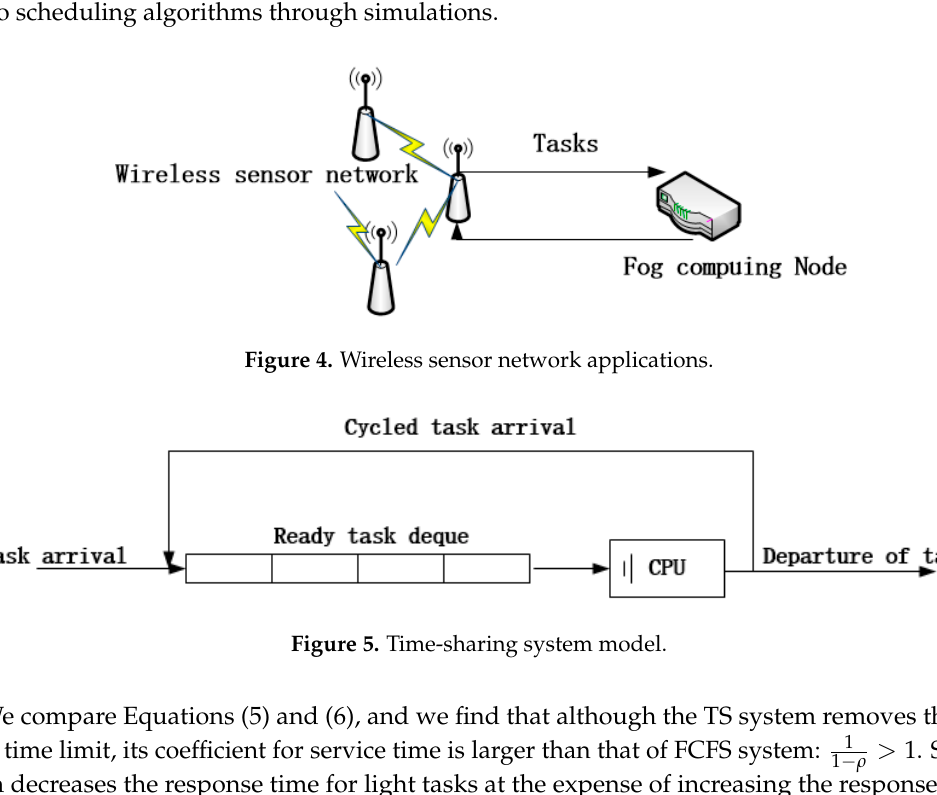
Figure 4. Wireless sensor network applications.